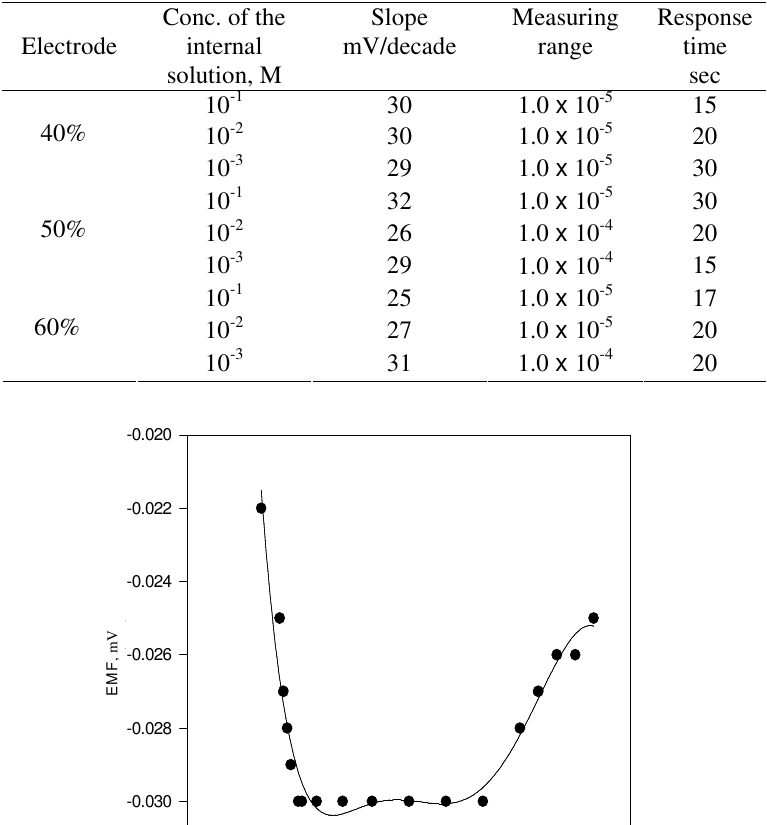
Table 3. Optimization of membrane ingredients for ZrWP based membrane.